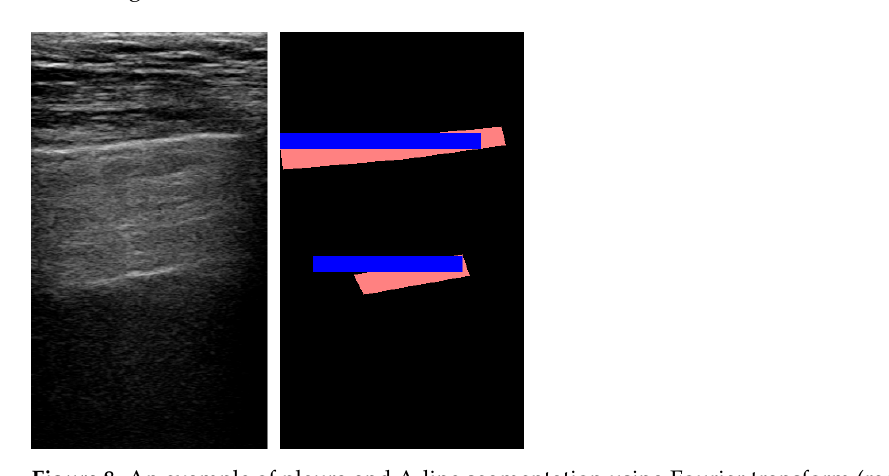
Figure 8. An example of pleura and A-line segmentation using Fourier transform (red: true mask; blue: predicted